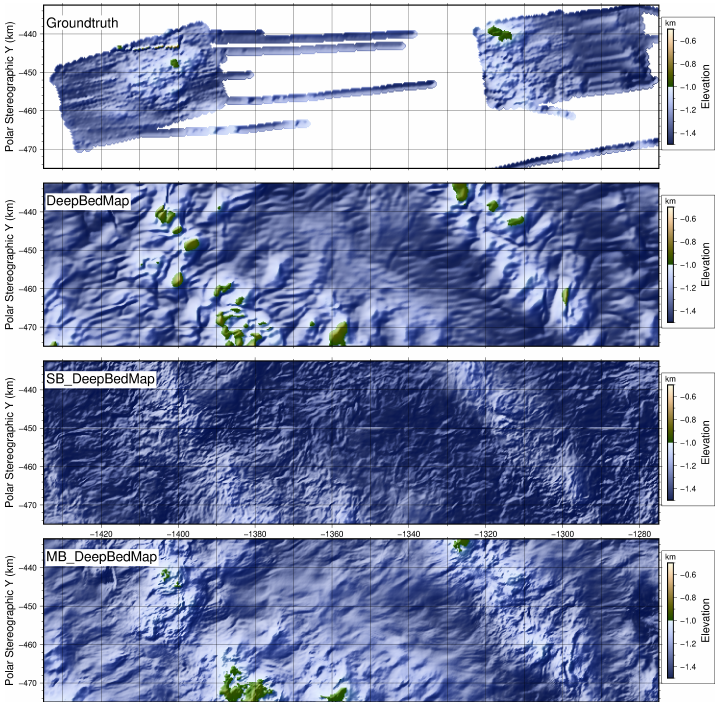
Figure 15. Comparison of bed elevation grid products over Thwaites Glacier. The ground-truth is from gridded Operation IceBridge